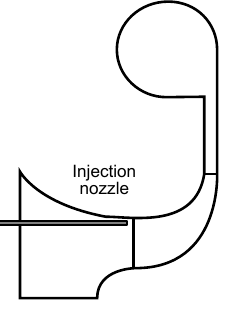
Figure 12. Schematic view of an injection nozzle in a centrifugal